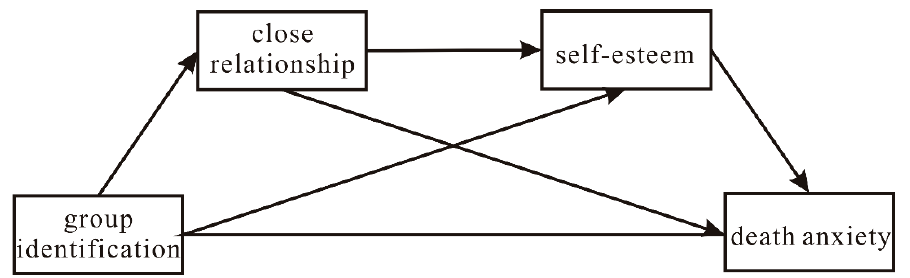
Figure 1. A conceptual model of group identification, close relationship, self-esteem, and death anx- Figure iety.